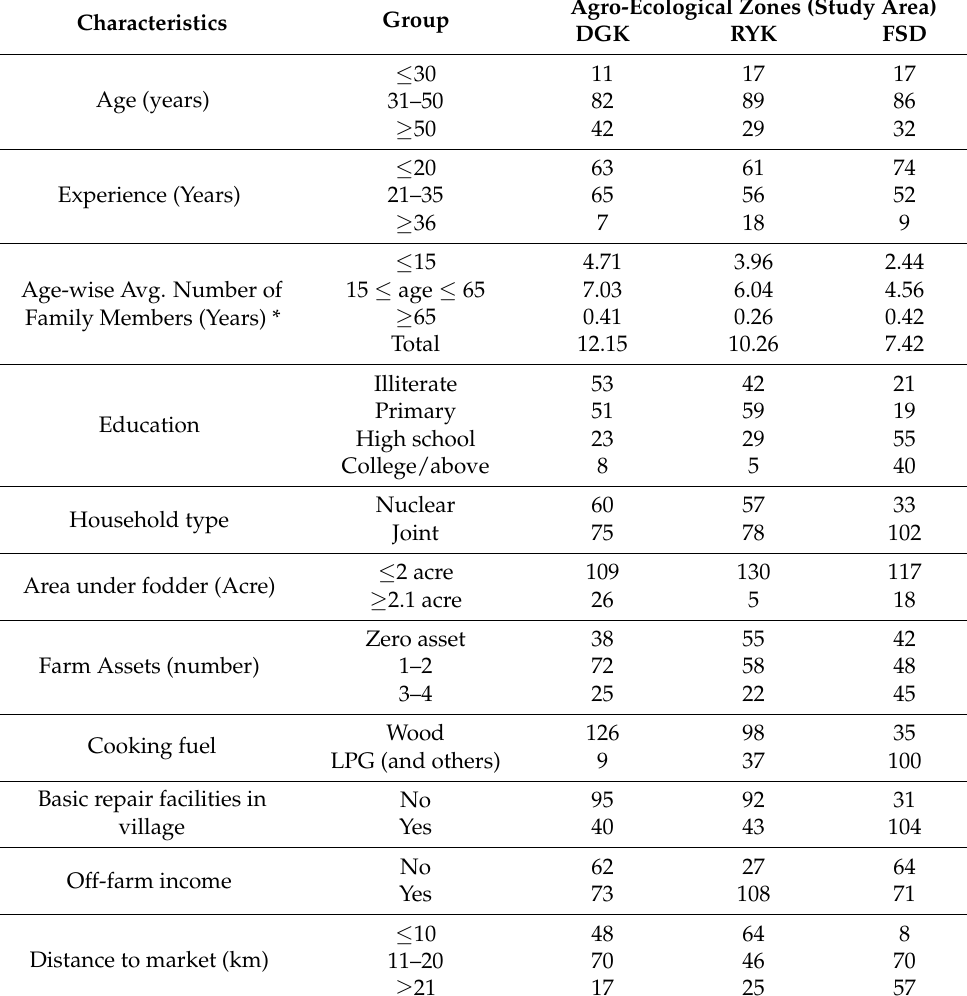
Table 2. Socio-demographic and economic characteristics of study